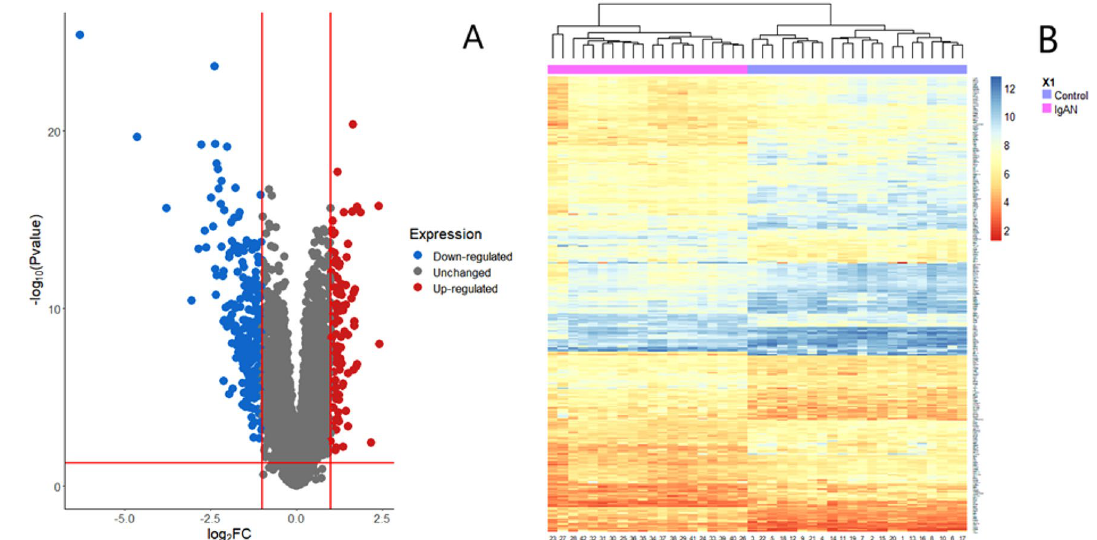
Figure 2. Identification and hierarchical clustering of DEGs for IgAN patients. ( A ) Volcano plot of DEGs which were generated using “ggplot2 version 3.3.6” package in R 63 (https:// cran.r- proje ct. org/ packa ge= ggplo t2) . Dodger blue represents down-regulated, gray represents no significant genes, and fire brick represents up-regulated DEGs. ( B ) Heatmap of the DEGs for IgAN patients which were generated using “NMF” version 0.24.0 package in R 64 (https:// cran.r- proje ct. org/ packa ge= NMF). The horizontal axis shows the number of patients and the vertical axis shows